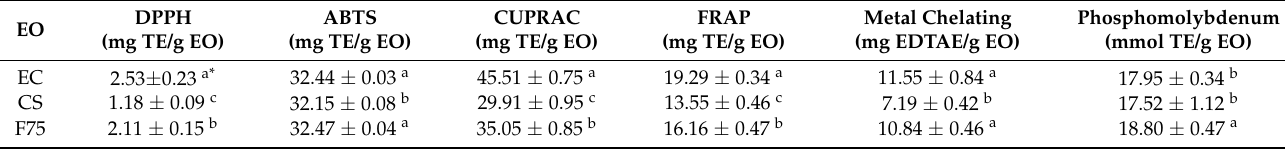
Table 6. Scavenging/reducing and metal-chelating properties of the tested hemp essential oils [25].